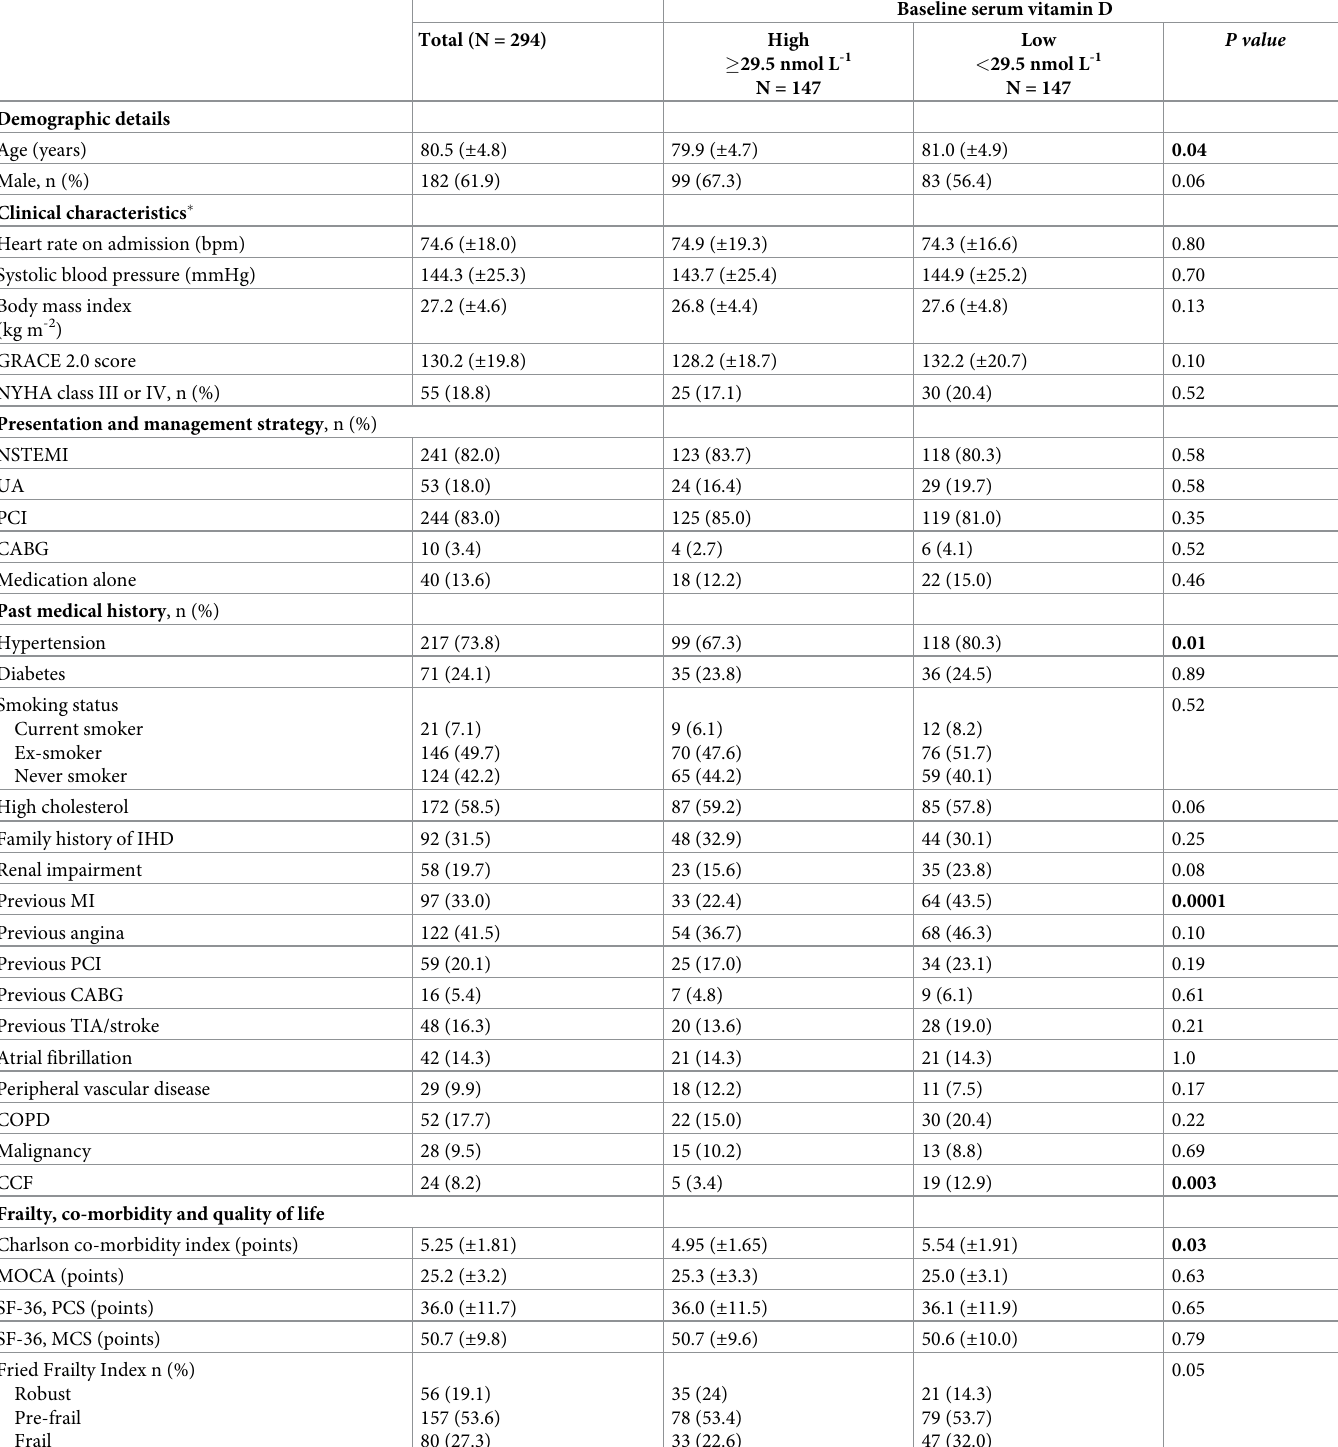
Table 1. Baseline characteristics of study participants grouped by serum vitamin